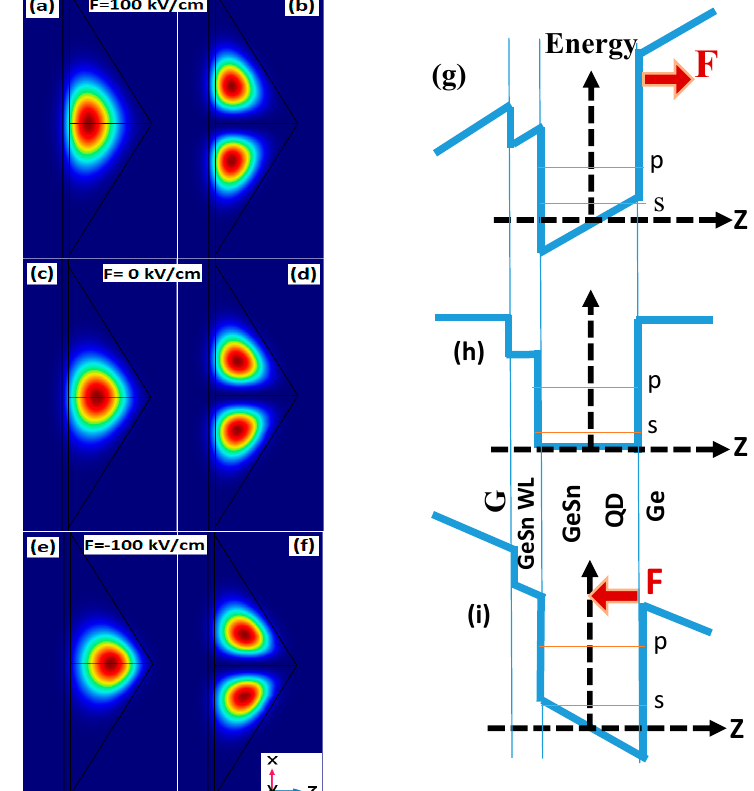
Figure 3. Probability density of s-state ( a , c and e ), p x- state ( b , d and f ) for GeSn QD with L = 40 nm as well as a simple schematic illustration of the Γ -band electron confining profile ( g , h and i ) respectively for F = 100 kV/cm, 0 kV/cm and − 100 kV/cm.